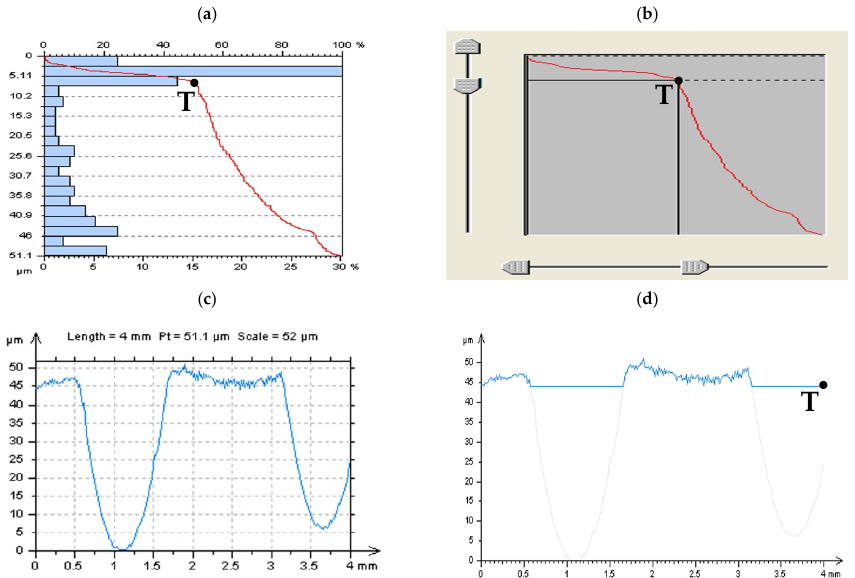
Figure 5. An Abbott-Firestone curve ( a ), thresholding (value) point T ( b ), measured profile ( c ), and the same profile with filled features/valleys ( d ) extracted from the cylindrical surface containing dimples.